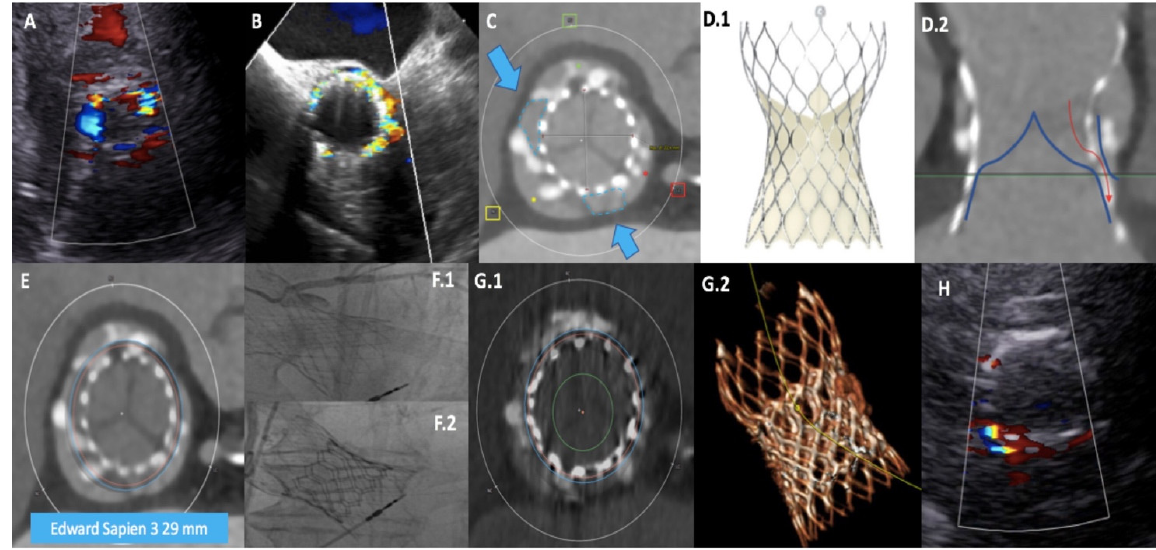
Figure 3. Multimodal imaging approach to assess the feasibility of ViV TAVR for PVL correction